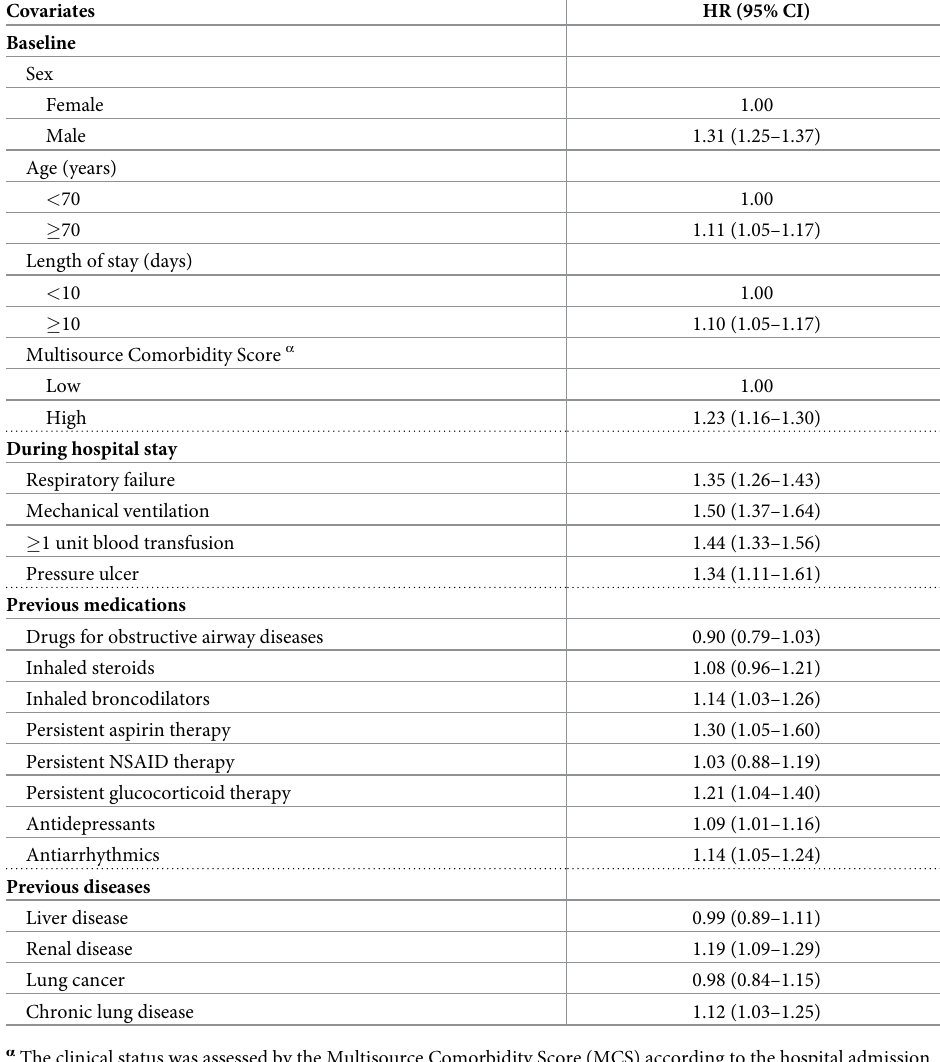
Table 2. Hazard Ratios (HR), and relative 95% Confidence Intervals (CI), of early rehospitalizations for pneumo- nia in the whole cohort (203,768 patients), estimated by a multivariable Cox proportional hazard